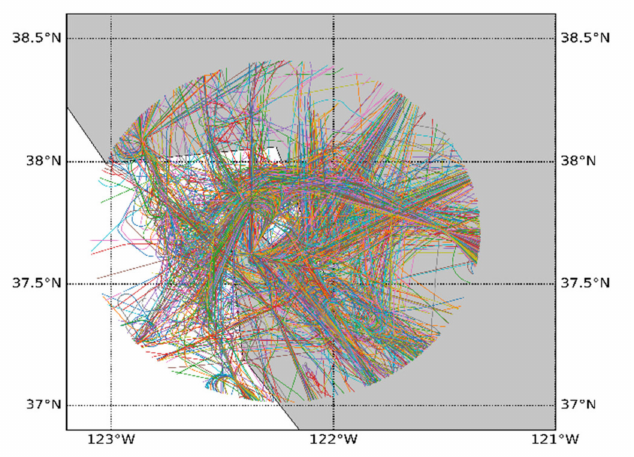
Figure 5. Flight trajectory within NCT on 1 January